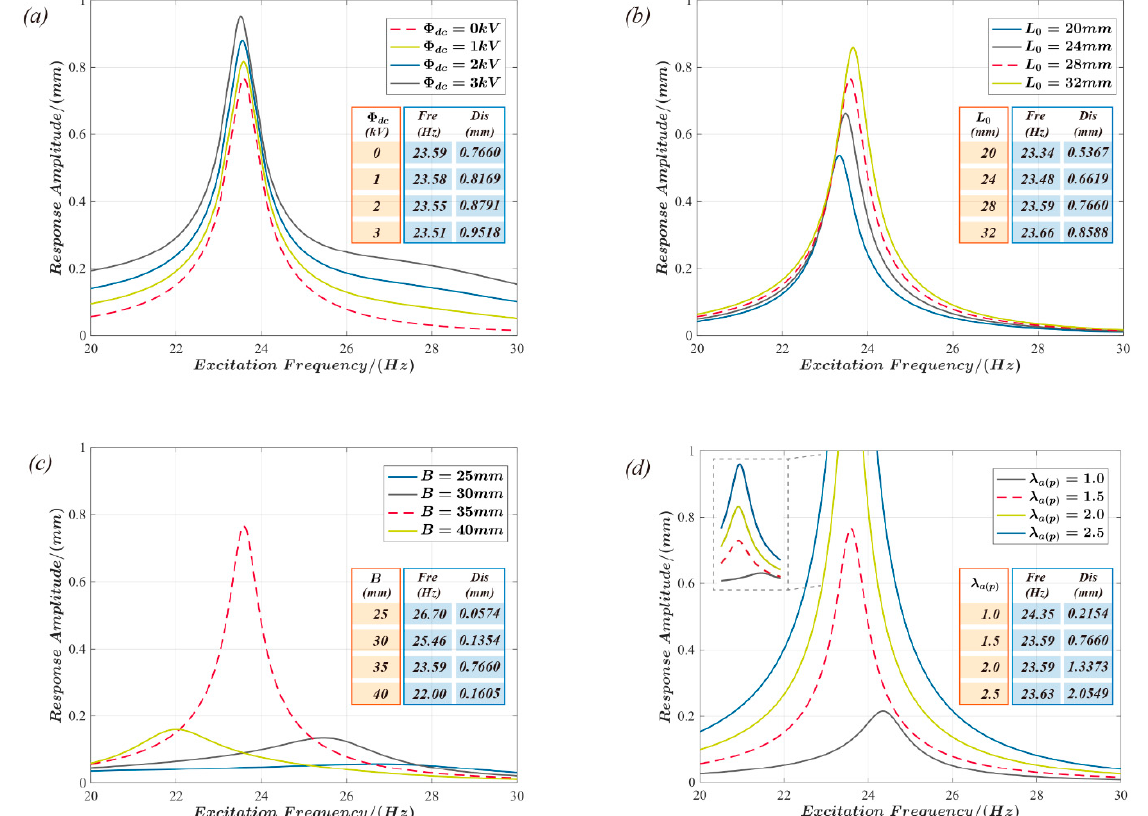
Figure 8. The influence of design and driving parameters on the resonant frequency and actuator’s response. ( a – d ): the influence of the excitation voltage bias component Φ dc , rigid connector length L 0 , rigid annular frame inner diameter B, and active film pre-stretch λ a ( p ) , respectively, on the resonant frequency of the actuator and its actuation response.